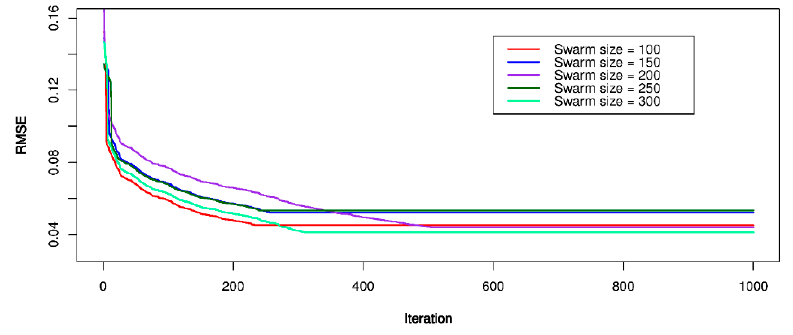
Figure 13. Performance of the PSO-SVR-P model on the training dataset.